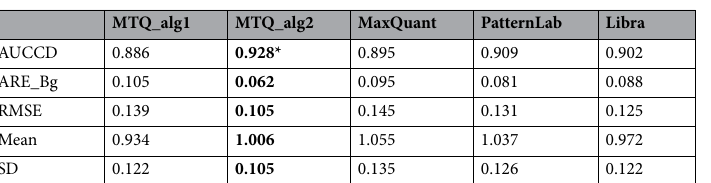
Table 1. Performance comparison of the four software tools on the 372 commonly quantifiable background proteins of Gatto-TMT6. *Boldface indicates the best measure among the four